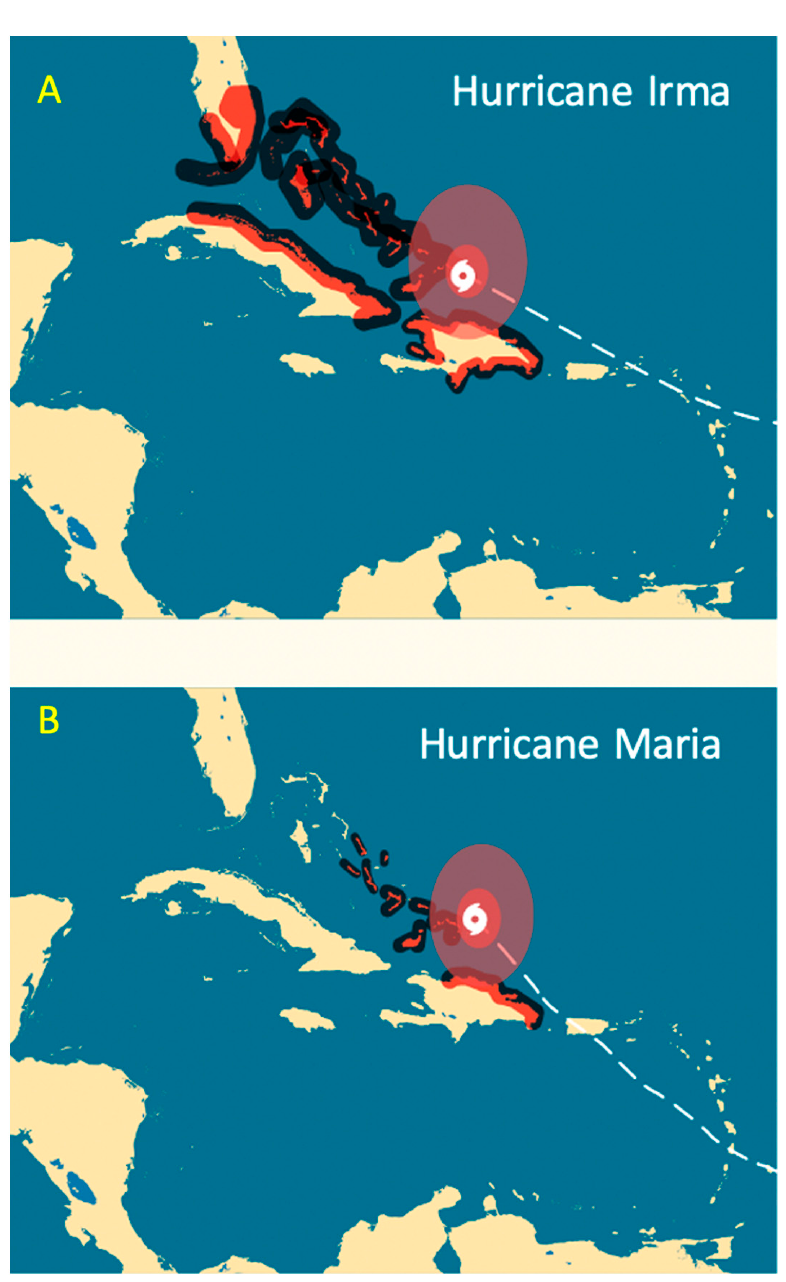
Figure 9. The hurricane tracks for ( A ) Hurricanes Irma (7 September 2017) and ( B ) Maria (21 September 2017).